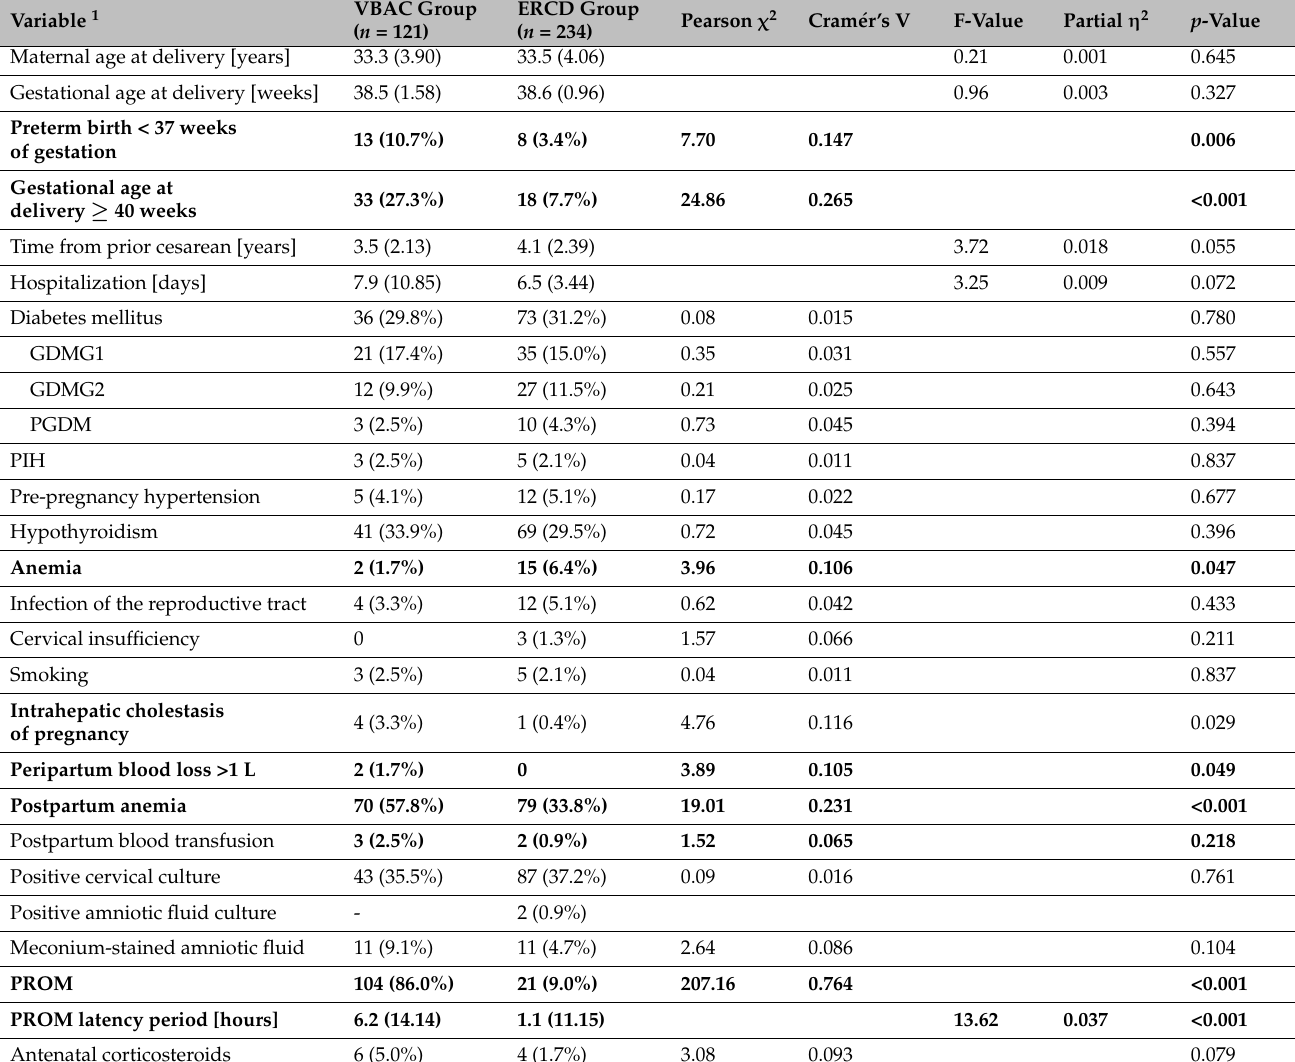
Table 1. Maternal and pregnancy